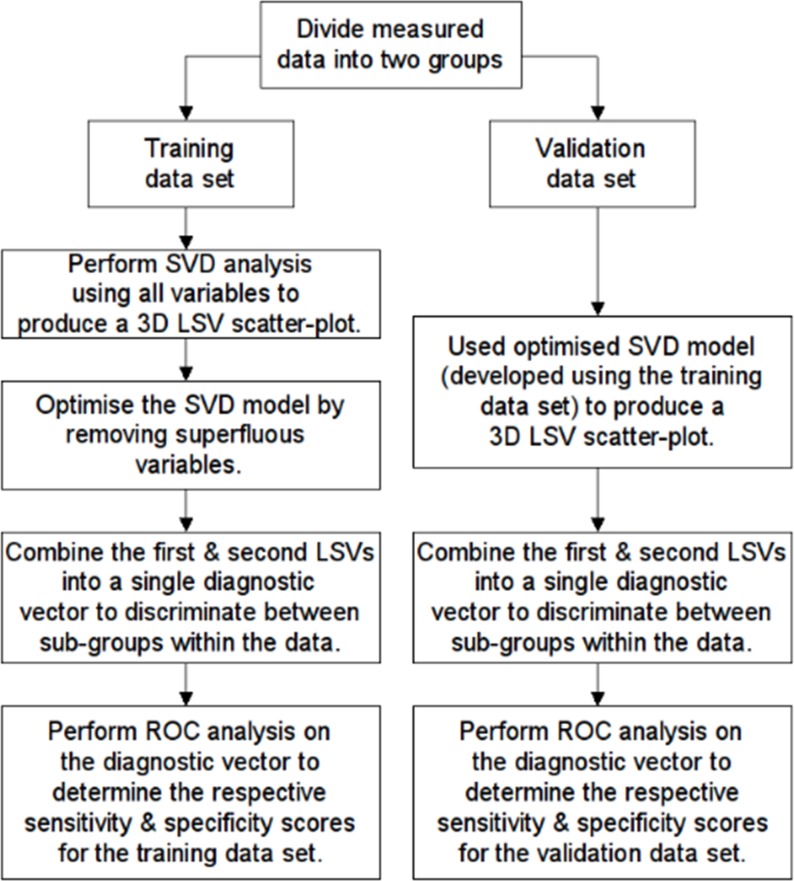
Schematic diagram of higher-dimensional analysis methodology employed in the study.(SVD = singular value decomposition; LSV = left singular vector).